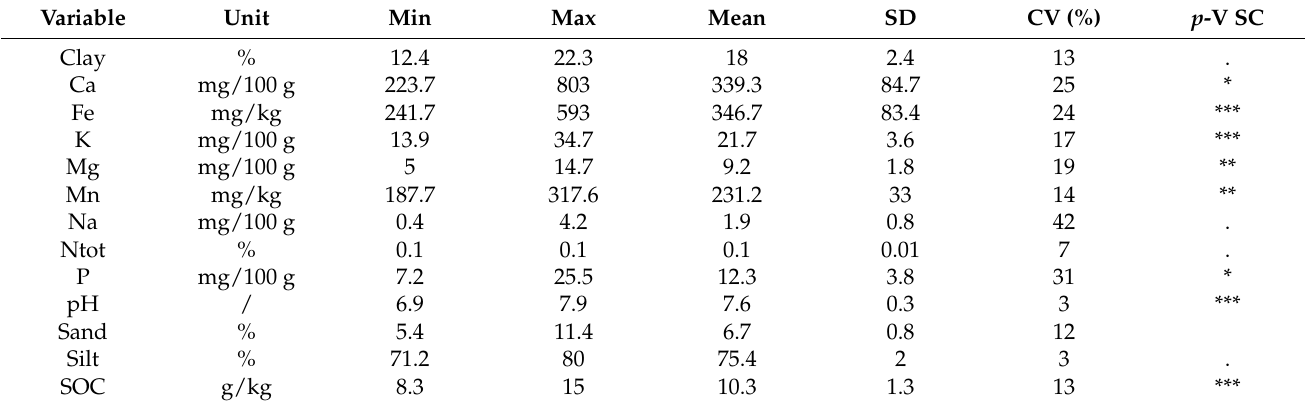
Table 6. Averaged, minimum, and maximal values of soil properties over the whole experimental field of 17 ha. The last column shows the conventional significance code of p -value ( p -V SC) of an analysis of variance (ANOVA) test for four groups of soil samples partitioned based on their location within the four parcels (A, B, C, and D) of the former field layout (see Figure 1). CV = coefficient